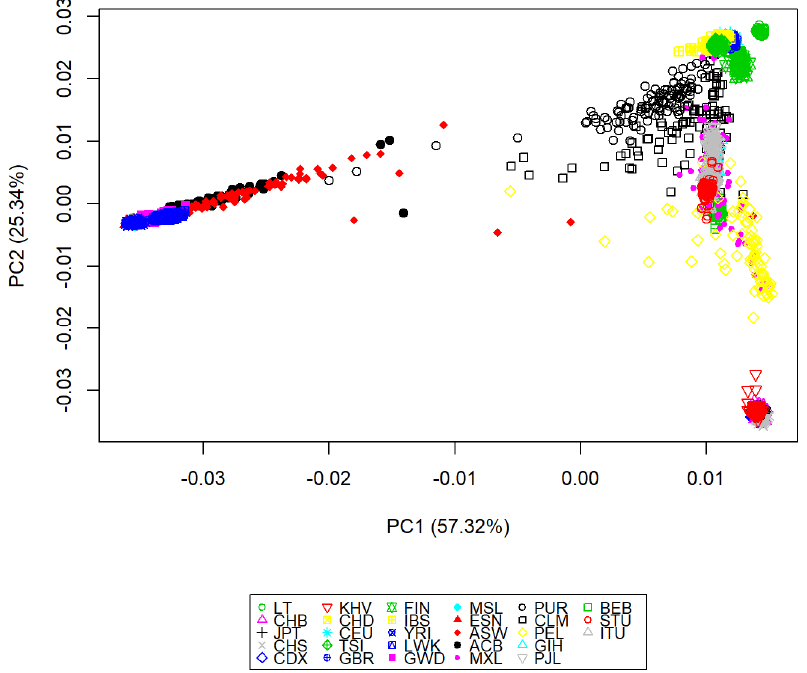
Figure 2. Principal component analysis of the first two PCs of individuals from Lithuania and 27 populations from the 1000 Genomes Project Phase3 dataset. Abbreviations as indicated in the text.